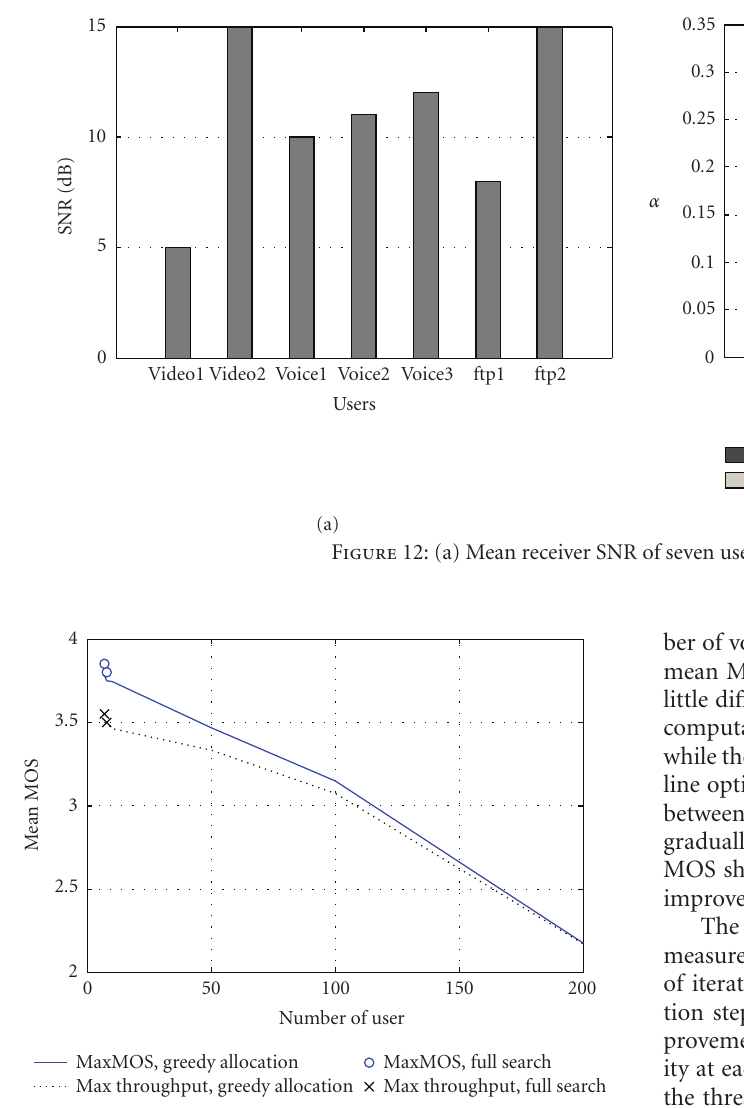
Figure 13: Mean MOS versus the number of users for the greedy algorithm and the full search